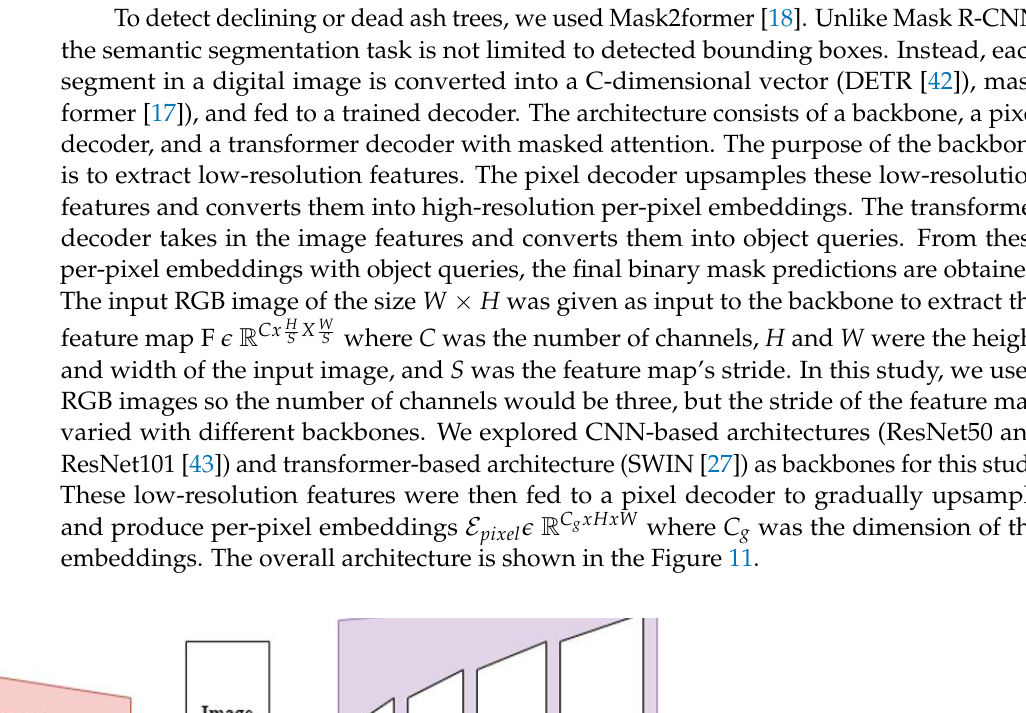
Figure 10. The overall workflow for the prediction of ash tree decline and death.